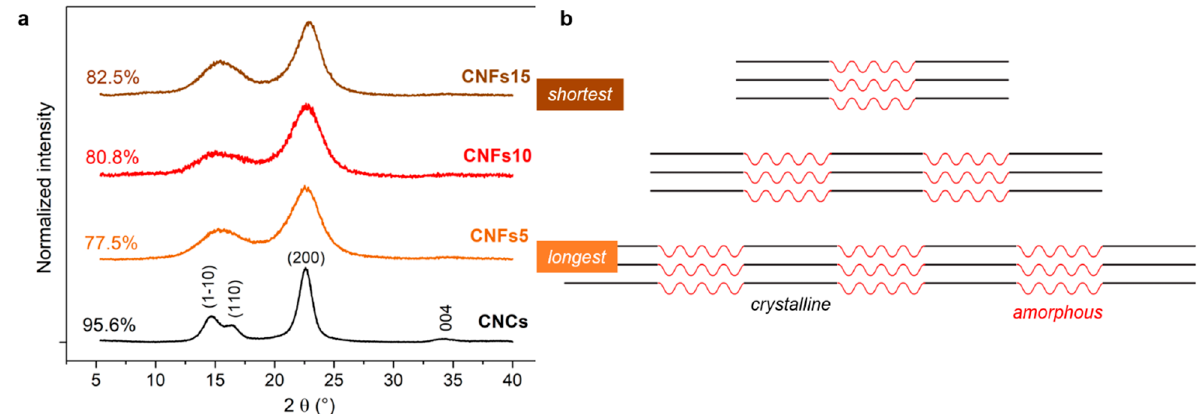
Figure 5. Shifted and normalized X-ray diffraction patterns of CNCs and CNFs, following a two-point baseline correction ( a ). The scheme ( b ) does not imply that depolymerization of amorphous domains is the only cause for a decrease in CNF length.